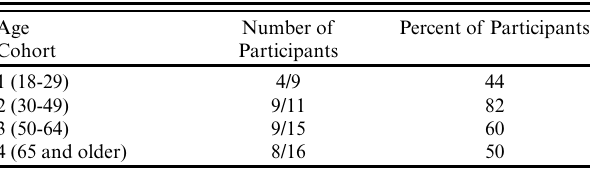
Table 4 . Observations of changing summer conditions by age cohort.